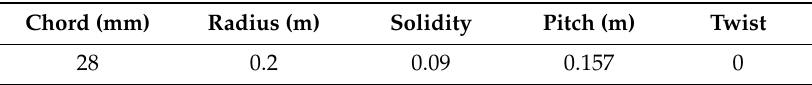
Table 1. Rotor parameters.